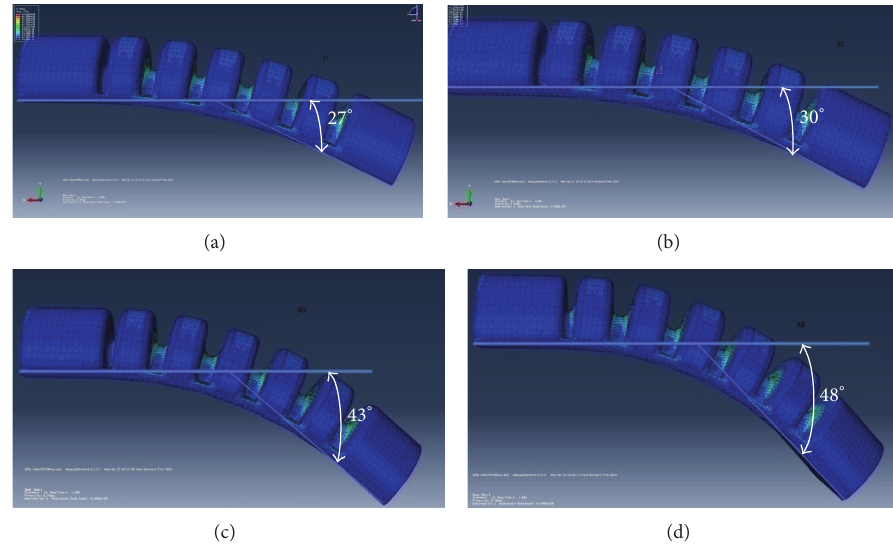
Figure 16: Deflection analysis of model 3 AFPA for various internal pressures (a) 90 kPa, (b) 120 kPa, (c) 150kPa, and (d) 180